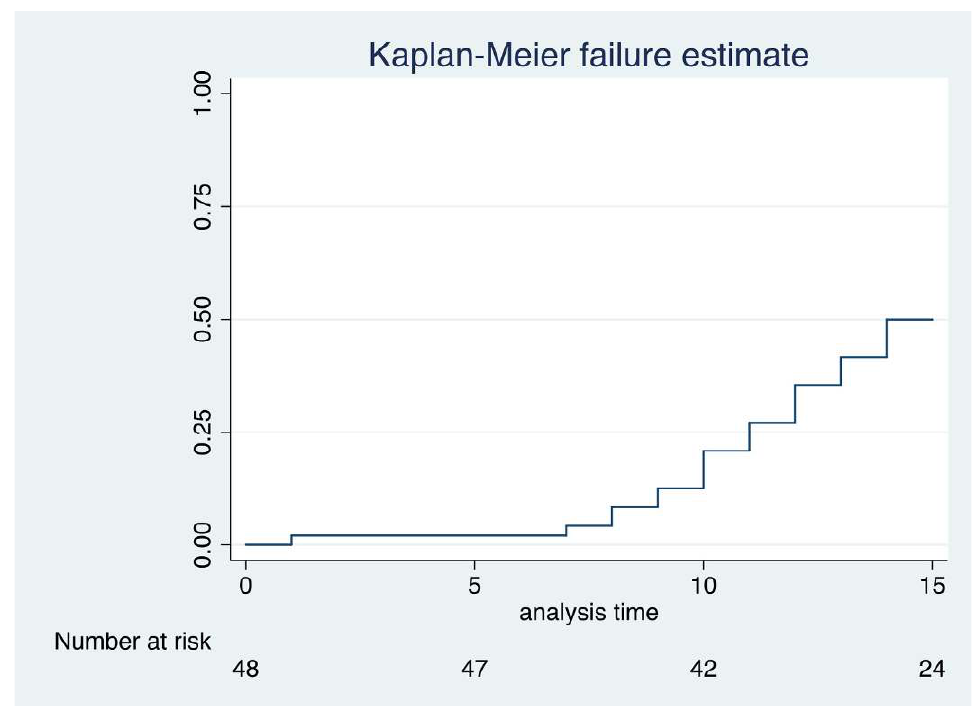
Figure 2: Cumulative distribution of failure times for Statewide Smoking Ban, U.S.,